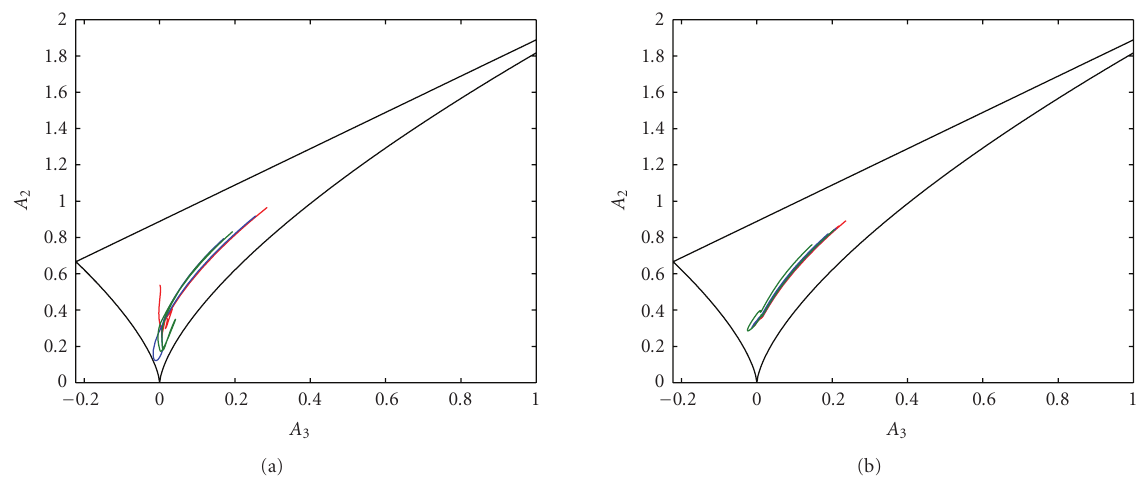
Figure 21: Anisotropy invariant map at (a) r ∗ = 0 . 3 and (b) r ∗ = 0 . 7 for Re = 10 6 , G = 0 . 02 and three flowrate coe ffi cients: C w = − 500 (red), C w = − 2500 (blue), and C w = − 10000